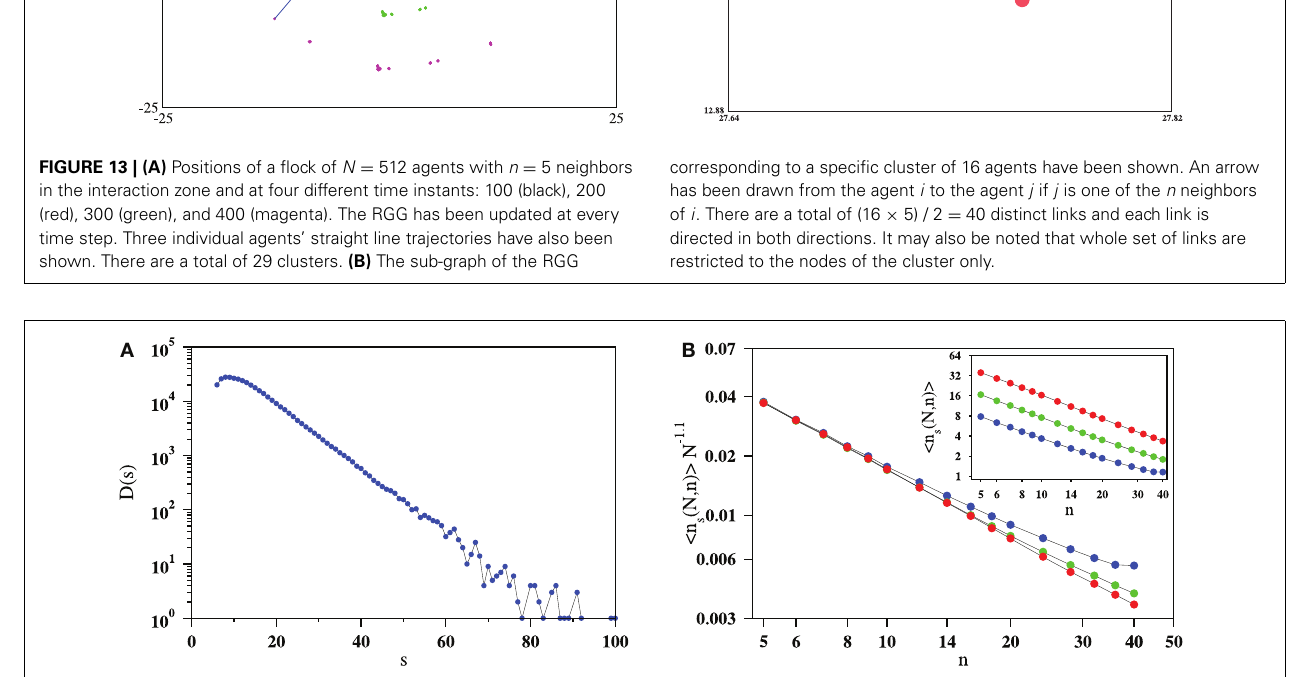
FIGURE 14 | (A) The frequency distribution D ( s ) of the cluster sizes s seems likely to have an exponentially decaying form exp ( − s / s c ) where s c ≈ 7 . 2. (B) The inset shows the plot of the average cluster size (cid:7) s ( N , n ) (cid:8) for N = 512 and